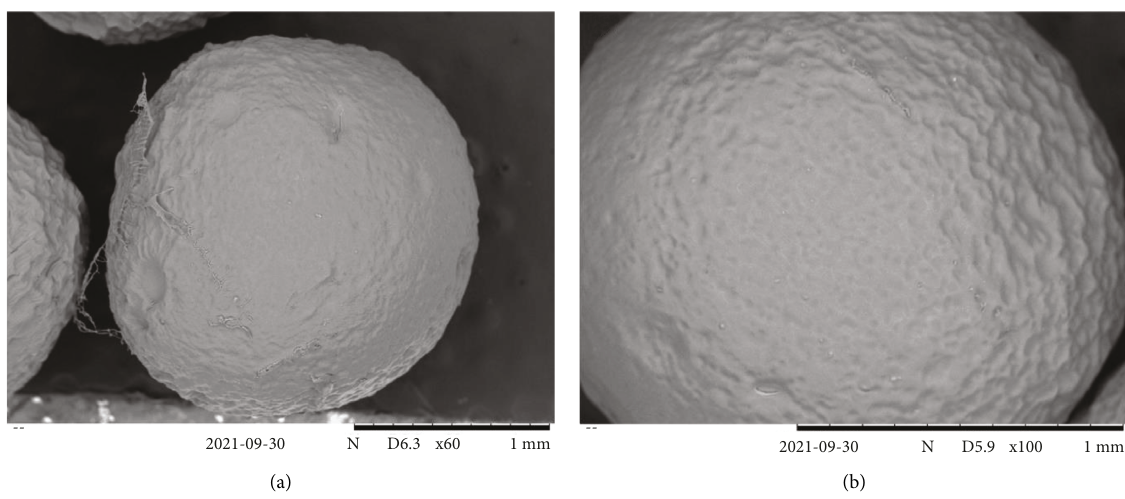
Figure 9: SEM of immobilized Escherichia coli cells. (a) 60K magnification and (b) 100K magnification.